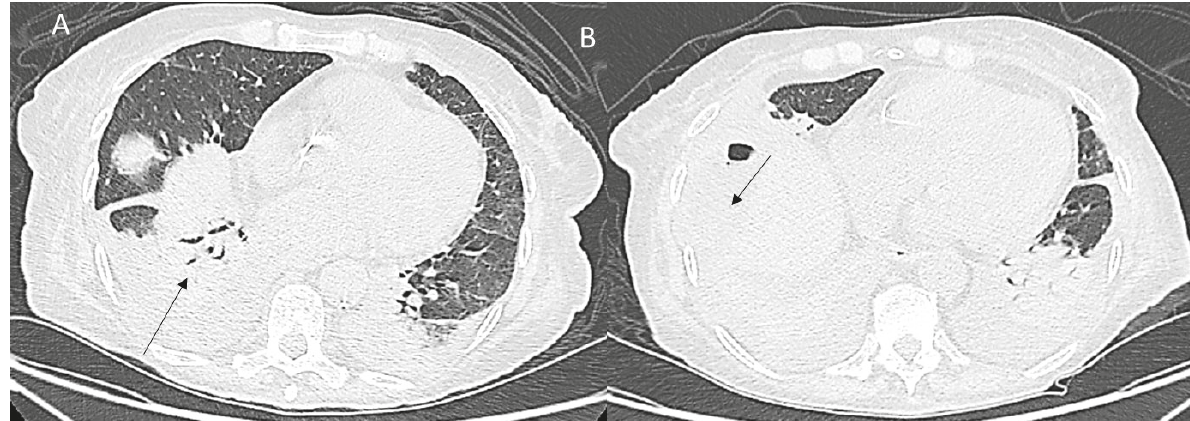
Figure 6. CT assessment ( A , B ) of treated HCC on IVa seg: pleural effusion and consolidation (arrow). The risk of pleural damage increases during the treatment of masses located on the hepatic dome, choosing an intercostal